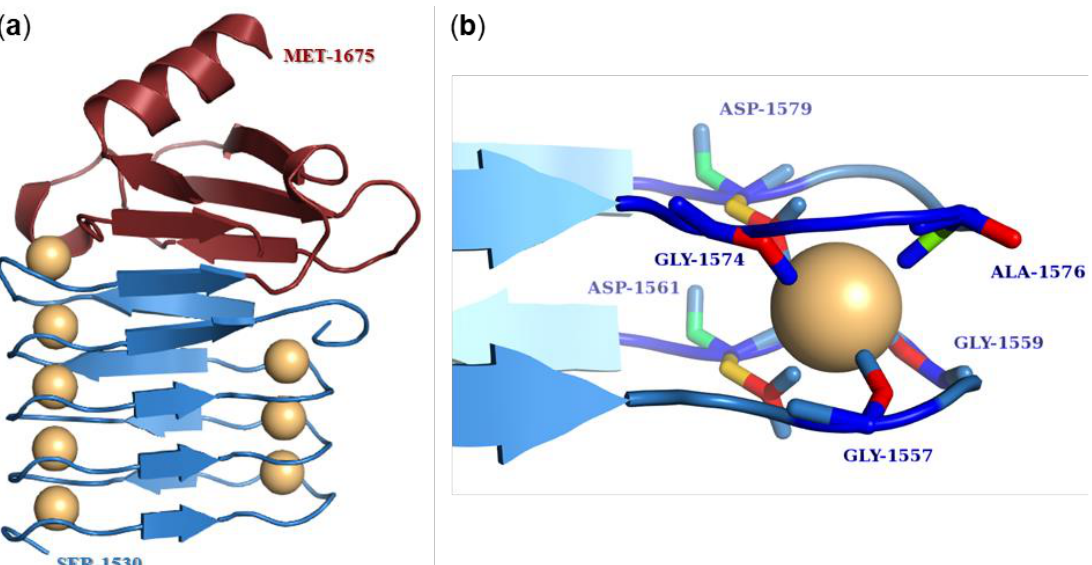
Figure 5. The crystal structure of residues 1530–1675 of CyaA. ( a ) The parallel β -roll structure of block V of the RTX domain and the capping structure of CyaA (PDB ID 6SUS). The blue color represents the nonapeptide repeats of block V, the red color represents the capping structure, and the calcium ions are shown in light orange. ( b ) A detailed view of the calcium-binding site within block V of the RTX repeats. Each nonapeptide motif forms two half-sites for calcium binding, with each calcium ion bound at a hexa-coordinated site between two consecutive turns. The residues whose side chains directly coordinate the calcium ion are highlighted.